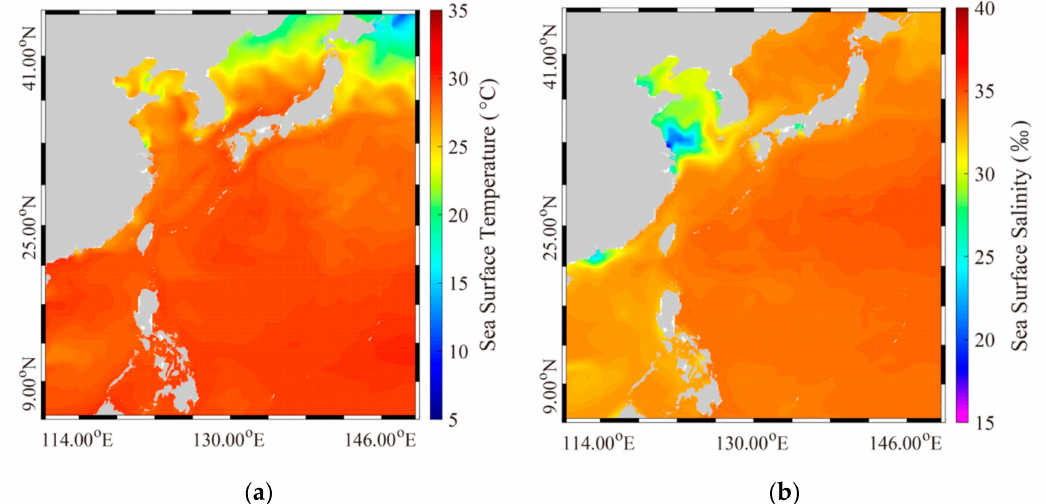
Figure 3. The Simple Ocean Data Assimilation (SODA) data used in the Stony Brook Parallel Ocean Model (sbPOM) on August 2012. ( a ) Monthly average sea surface temperature. ( b ) Monthly average sea surface salinity.